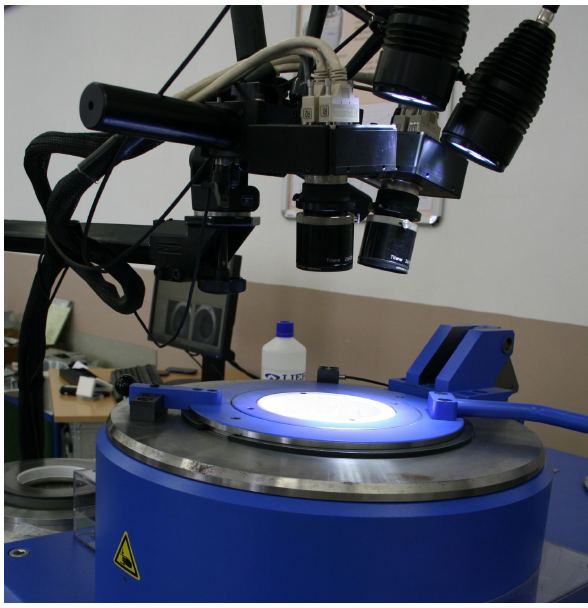
Figure 2: Device for estimating of FLC by Nakajima test Figure 3: Combination tool for deep drawing and redrawing opera-